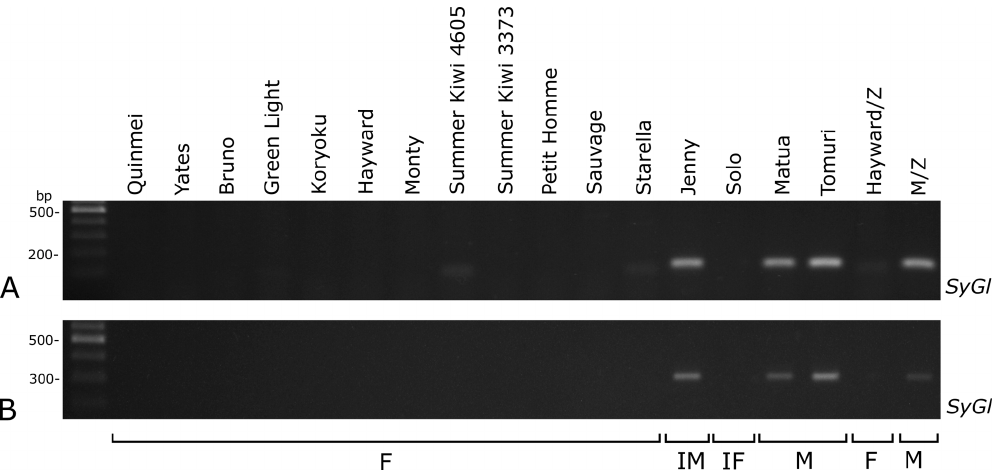
Figure 4. Amplification bands of the SyGl genic intron/exon ( A ) and SyGl 3 ′ promoter region ( B ) in selected cultivars of Actinidia chinensis var. deliciosa . Hayward/Z and M/Z indicate cv. Hayward and a male pollinator obtained from Zespri Internationatl Ltd. F—female, IF—inconsistent female, IM—inconsistent male, M—male.